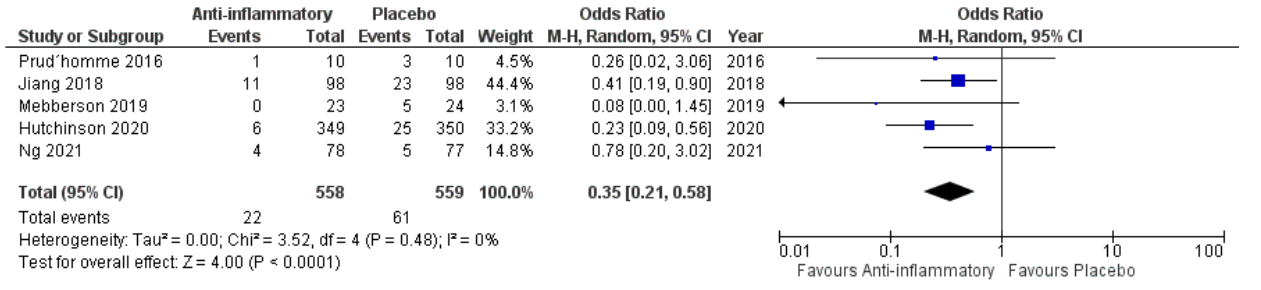
greater the weight given because of the narrower 95% CI. Diamond represents the odds ratio of the overall data.